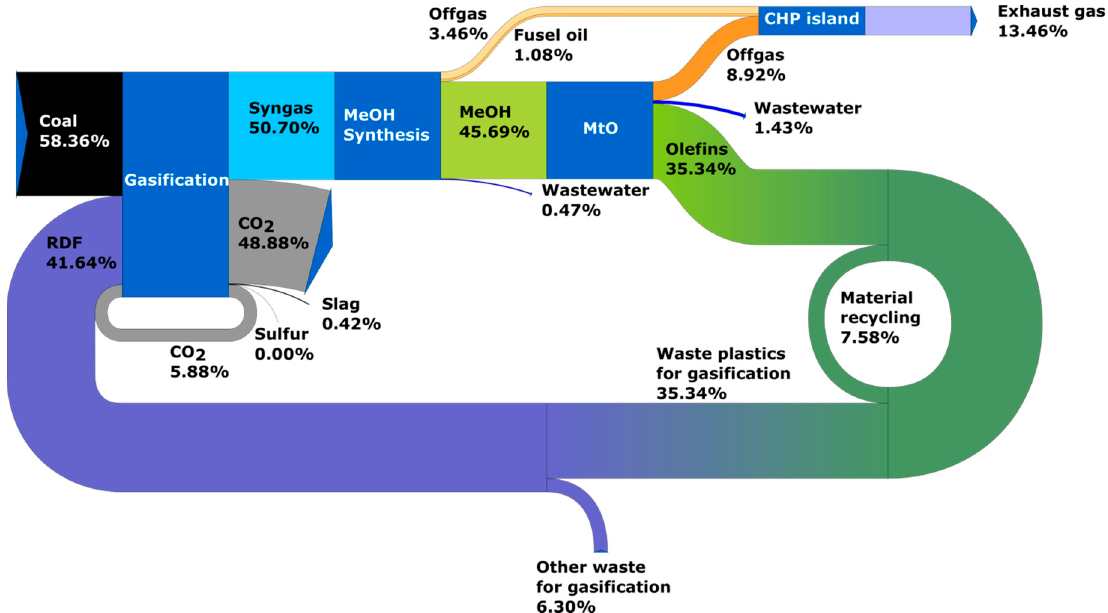
Figure 10 . Carbon element distribution in olefins from hard coal and RDF production system (2050).